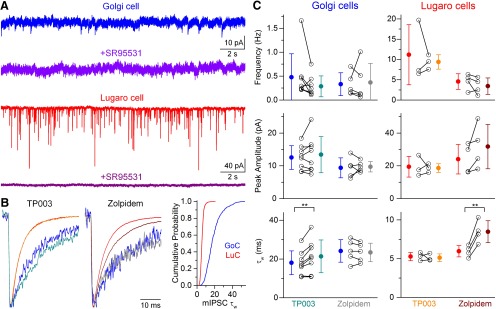
GoCs and LuCs have distinct mIPSC properties and different GABAAR α subunit content. A, Continuous current recordings from a GoC (blue) and a LuC (red) in the presence of 1 μm tetrodotoxin before and after the application of 20 μm SR95531 (traces below). Note the greater frequency and larger amplitude of mIPSCs in the LuC, and that all currents were eliminated by the GABAAR antagonist. B, Average, peak-scaled traces from example cells before (GoC, blue; LuC, red) and after bath application of 100 nm TP003 (left: GoC, teal; LuC, orange) or 100 nm zolpidem (middle: GoC, gray; LuC, dark red). Note the much faster mIPSC decay and selective prolongation by 100 nm zolpidem in the LuC, compared with the slower decay and selective prolongation by 100 nm TP003 in the GoC. Right, The cumulative probability distributions of τw of all individually fitted mIPSCs in GoCs (blue; n =408 mIPSCs) and LuCs (red; n = 2300 mIPSCs). C, Summary of mIPSC mean frequency, peak amplitude, and τw before (GoCs, blue; LuCs, red) and after bath application of 100 nm TP003 or 100 nm zolpidem. Note the large variance in τw in the population of GoCs, and that GoCs with a slower decay show a greater prolongation upon TP003 application. **p < 0.01 (repeated-measures parametric ANOVA, Tukey’s unequal n HSD post hoc test).